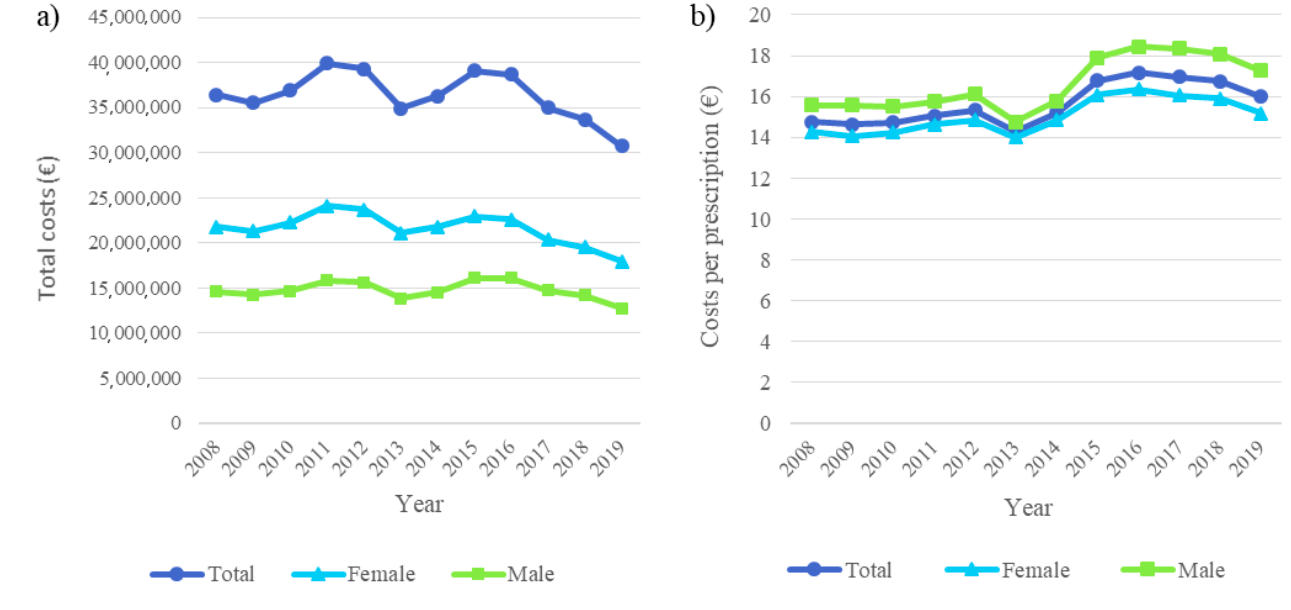
Figure 4. Antibiotic costs in Finland from 2008–2019. ( a ) Total costs. ( b ) Costs per prescription.